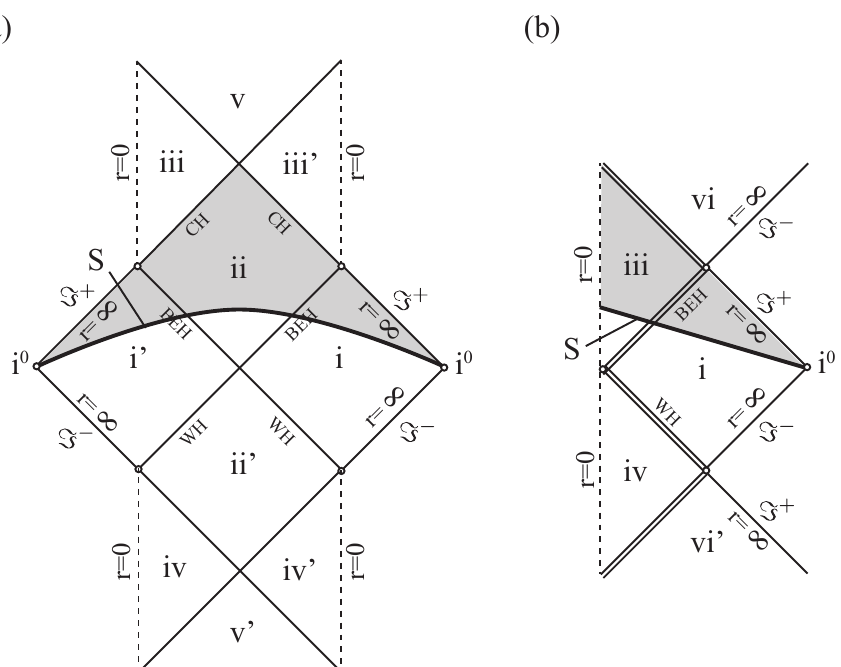
Figure 1 . Penrose diagrams of the Bardeen black hole with (a) two non-degenerate horizons and (b) one degenerate horizon. The symbols = +( − ) and i 0 stand for the future (past) null infinity and spacelike infinity, respectively. BEH, CH, and WH stand for the black-hole event horizon, Cauchy horizon (as an inner horizon), and white-hole horizon, respectively. A double line in (b) represents a degenerate